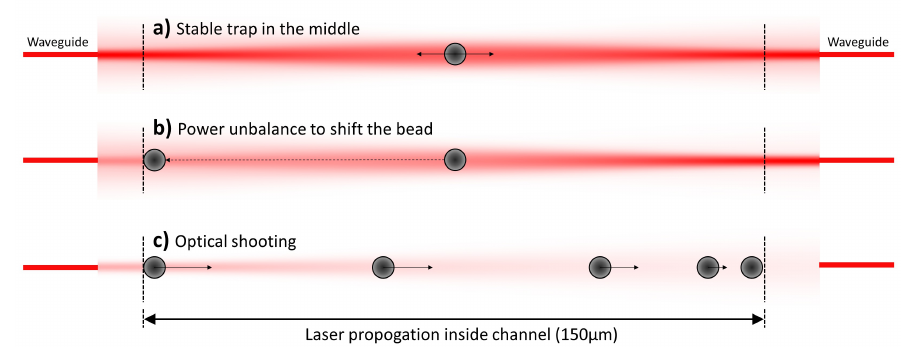
Figure 3. Optical shooting experimental protocol. ( a ) A single bead is captured by two laser beams with equal power; ( b ) the bead is shifted to the left side by decreasing the optical power emitted from the left waveguide; ( c ) once the bead is close to the left channel border, the opposite laser beam is abruptly blocked and then the optical shooting procedure is performed, i.e., the microbead is moved only by the left laser across the whole channel and the movement is recorded by a charge coupled device (CCD) camera.